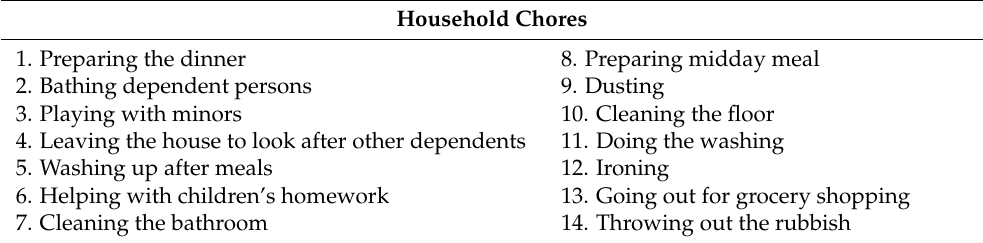
Table 3. List of unpaid household chores and the care of children and relatives considered in both